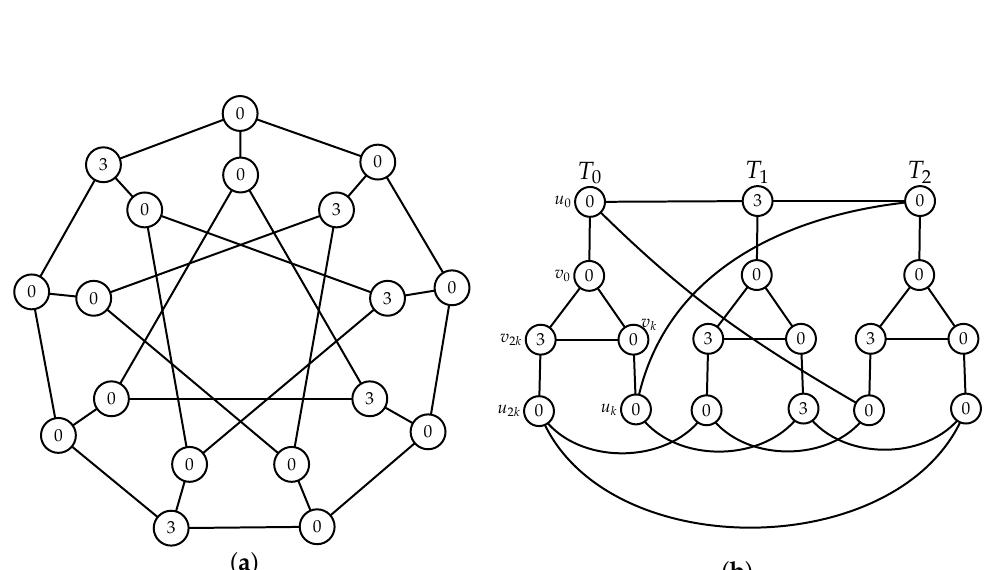
Figure 1. A double Roman dominating function (DRDF) of P ( 9,3 ) . Standard drawing ( a ) and alternative drawing used in this work ( b